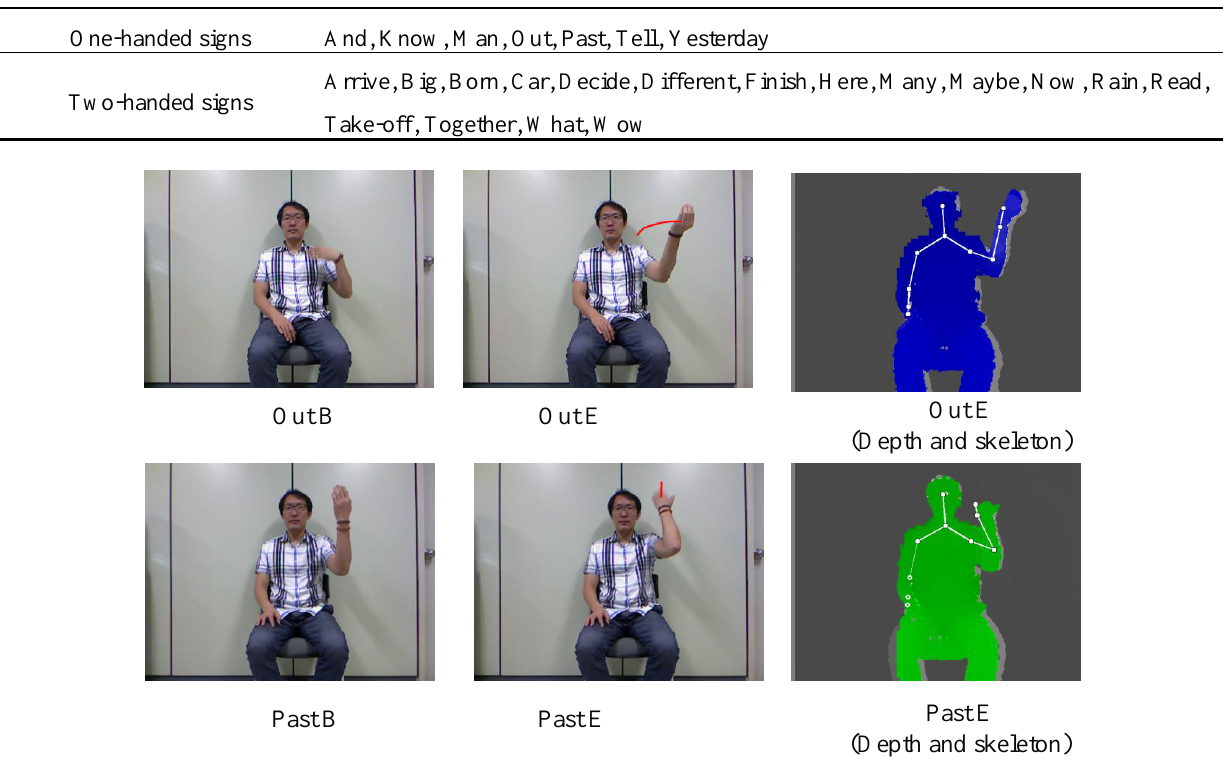
Figure 5. Two examples of ASL signs; B and E indicate means beginning and end,